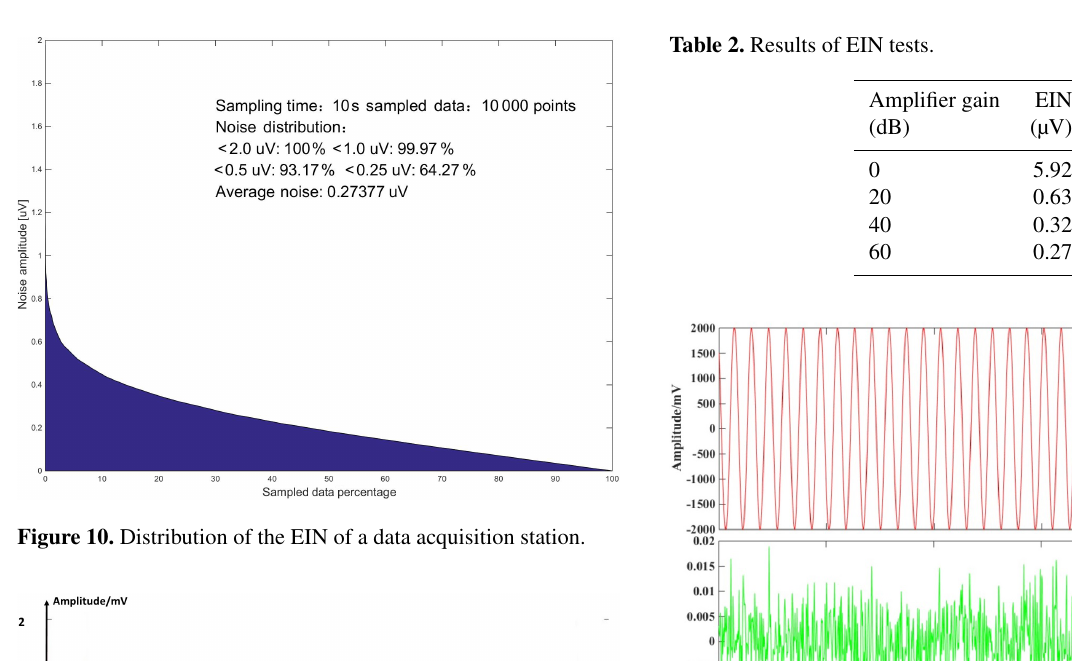
Table 2. Results of EIN tests.